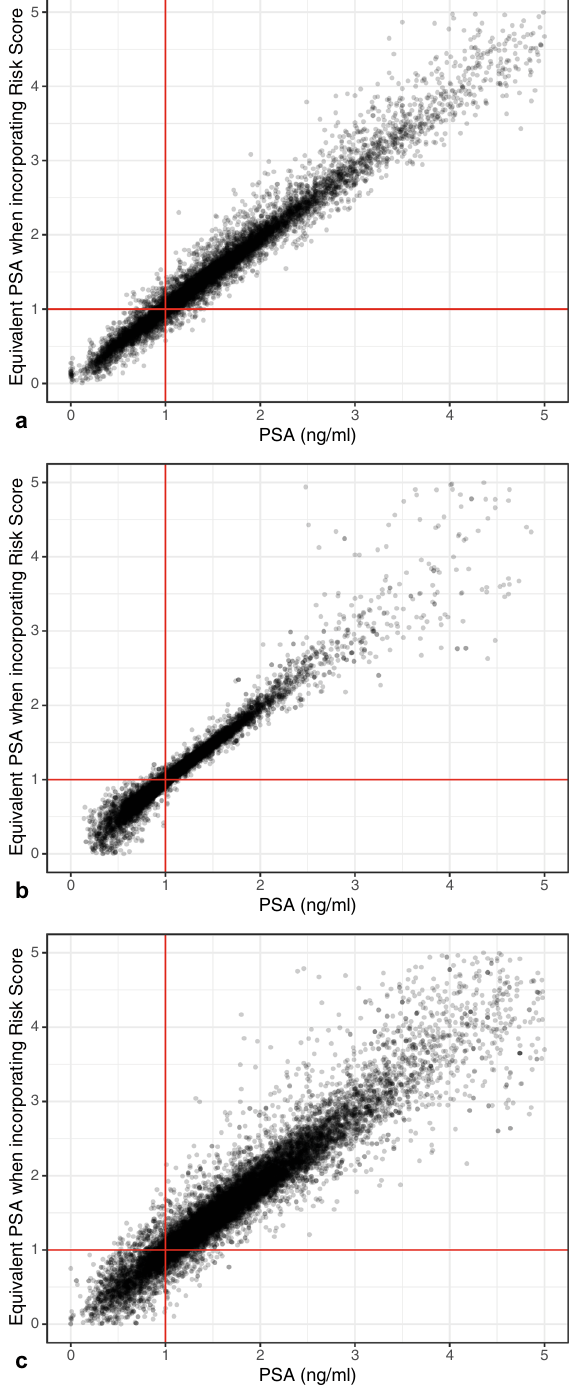
Fig. 2 Reclassi fi cation by modi fi ed PRACTICAL Risk score (125 SNPs). Reclassi fi cation shown in a the MDC cohort, b men sampled at age 50 in the VIP cohort, and c men sampled at age 60 in the VIP cohort. The x -axis is total PSA, and the y-axis is the equivalent total PSA based on predicted probability after incorporating the PRACTICAL risk score, for the outcome of prostate cancer metastasis or death (VIP) or prostate cancer death (MDC) within 20